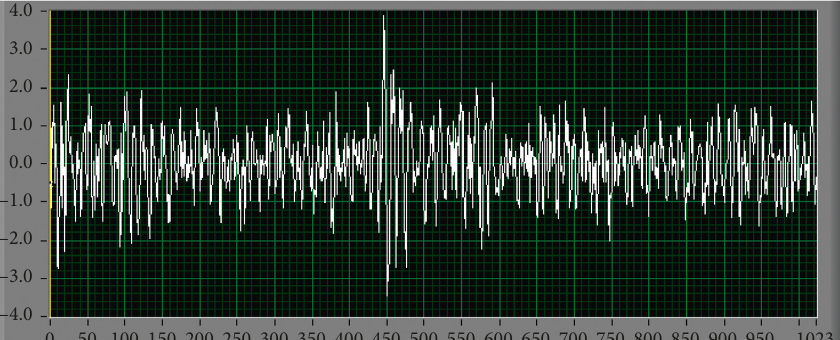
Figure 5: Vibration image in an inner wear state.